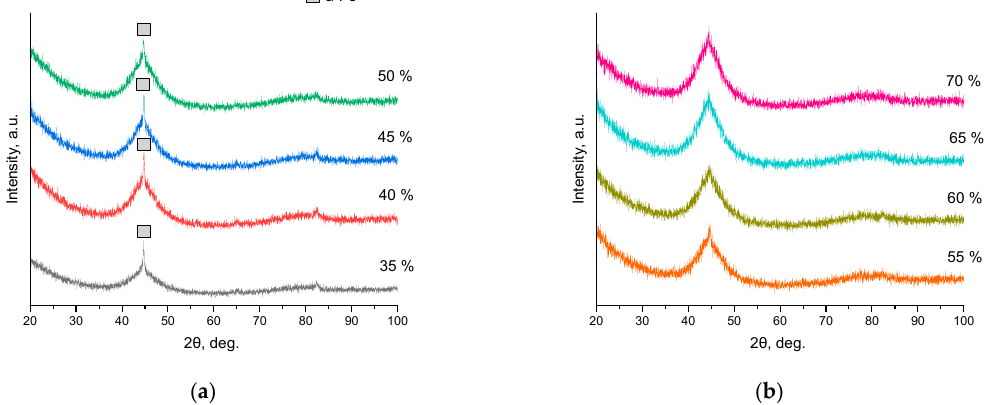
Figure 5. XRD patterns of the Fe 66 Cr 10 Nb 5 B 19 detonation coatings obtained at different explosive charges. Table 1. Content of the crystalline phase, porosity, and Vickers microhardness of the Fe 66 Cr 10 Nb 5 B 19 detonation coatings. For the content of the crystalline phase and porosity, the standard deviations are given. For Vickers microhardness, the confidence intervals are given (for a confidence level of 0.95). Content of the Explosive Charge, % Crystalline Phase, Explosive